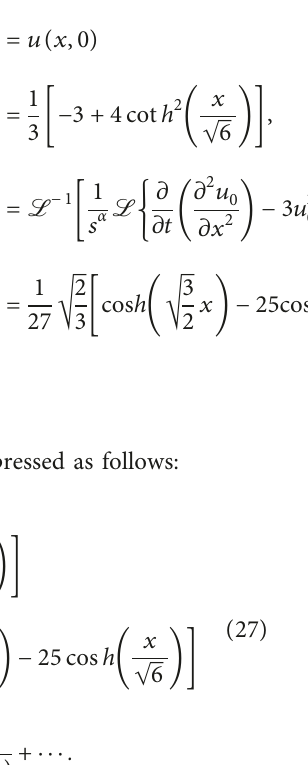
Figure 1: Surface solution between the proximate and the exact solutions w.r.t initial condition (18), when α (b) Exact